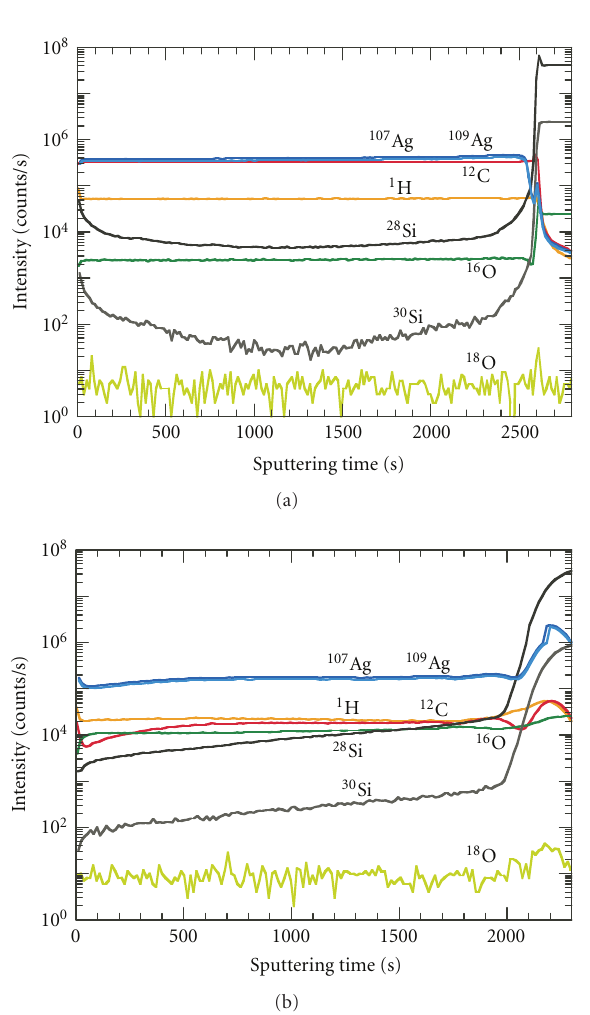
Figure 4: Secondary ion mass spectrometry depth profiles of (a) 4.5at.% silver and (b) 61.3 at.% silver-incorporated DLC films.